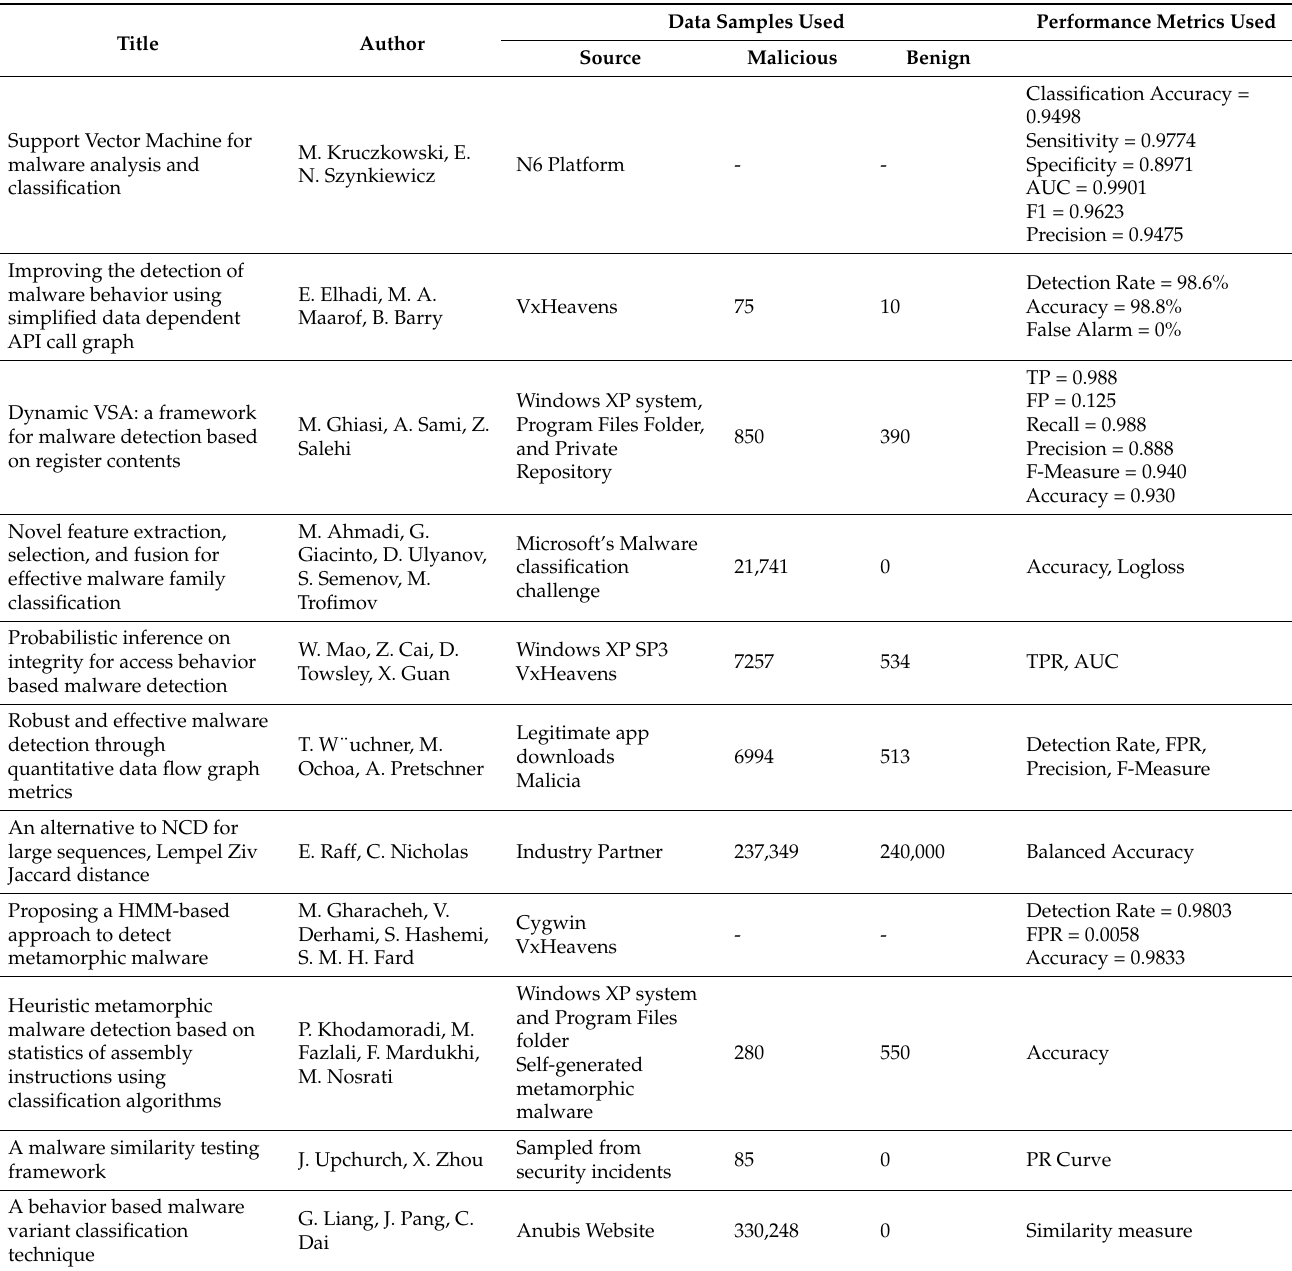
Table 2. Datasets and Performance Metrics Used in Literature Proposing Machine Learning Methods for Malware